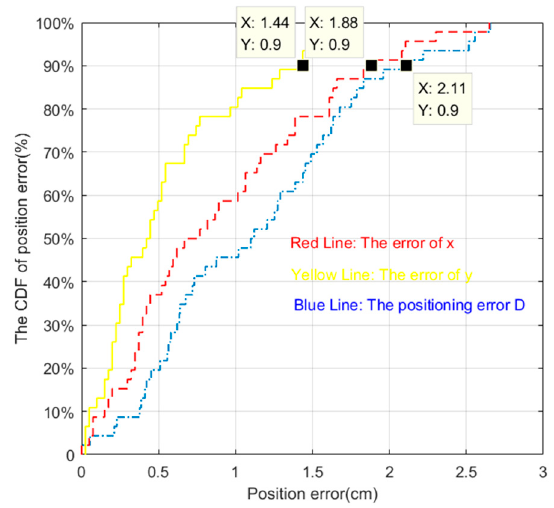
Figure 21. The CDF of positioning error when nearly 50% of the area of the LED was shielded.